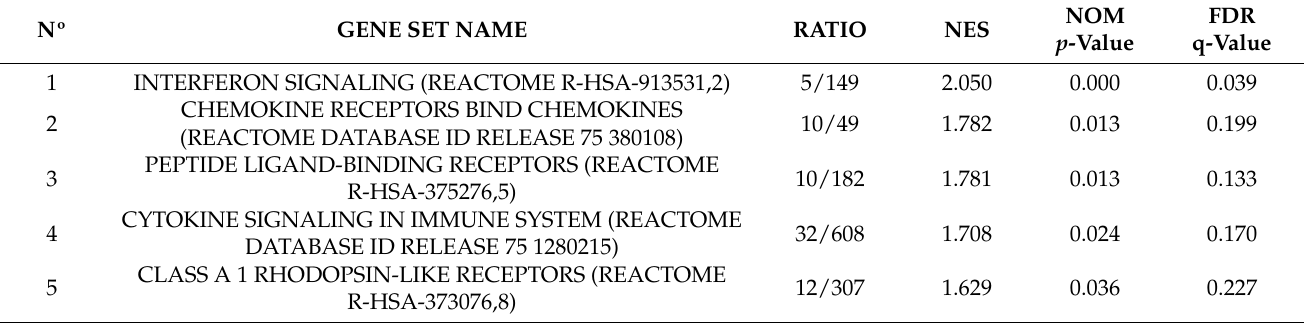
Table 2. Gene sets upregulated in one day post